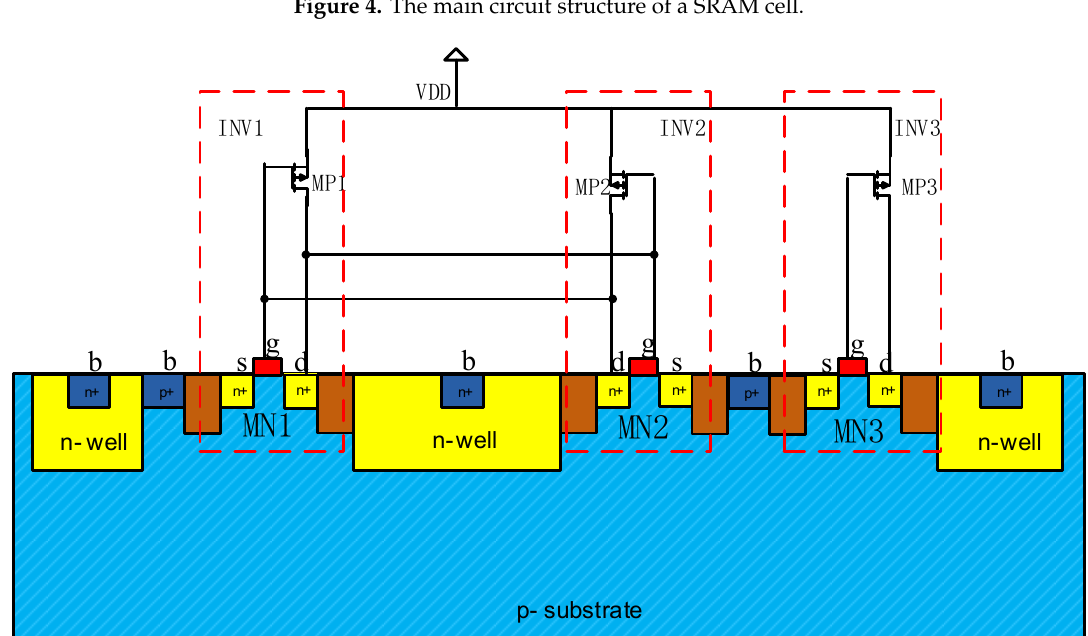
Figure 5. Particle strike the drain of NMOSFET transistor in a storage cell of SRAM.